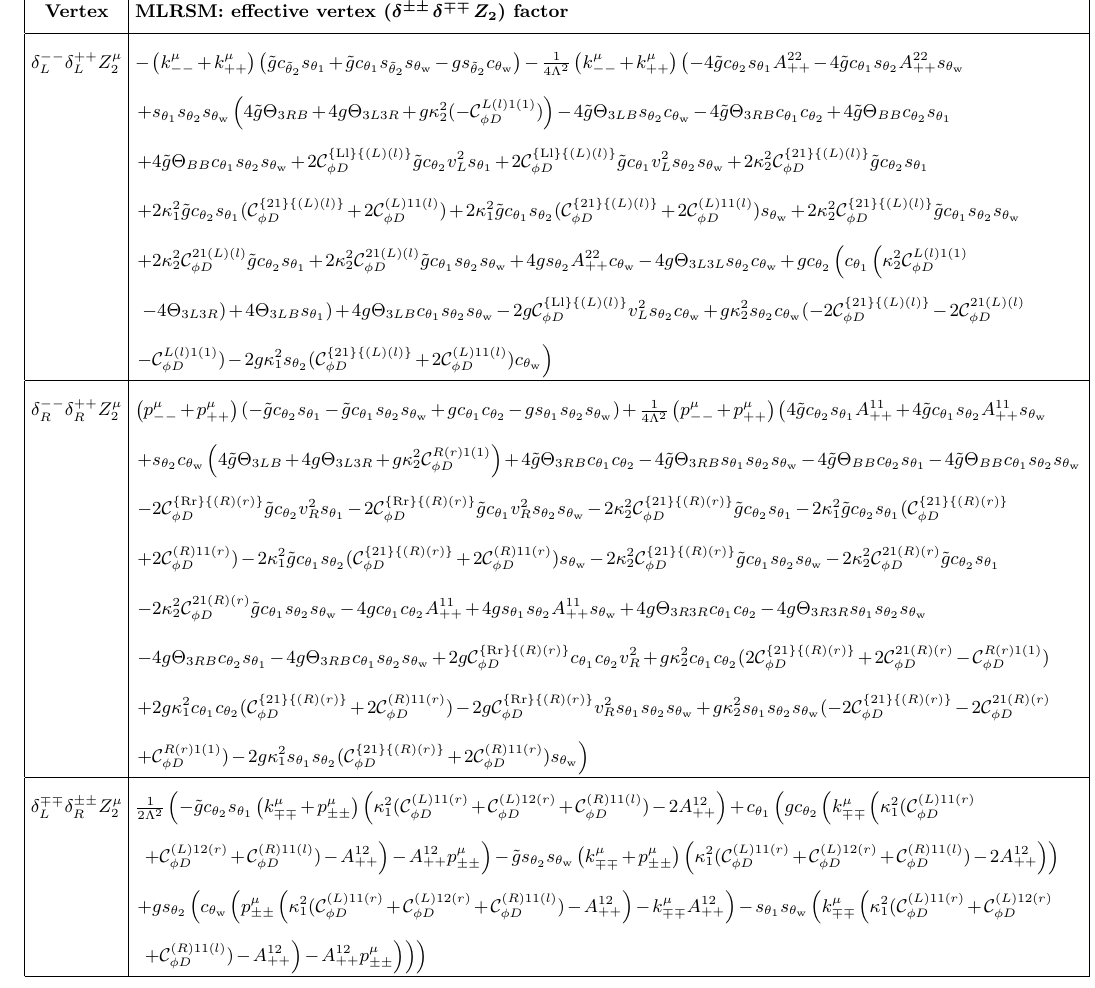
Table 41. MLRSM: coupling of a pair of doubly charged scalars ( (cid:14) (cid:6)(cid:6) ) with a neutral gauge boson ( Z 2 ). Here, s (cid:18) = sin (cid:18) i and c (cid:18) = cos (cid:18) i . k (cid:22) and p (cid:22) are the four momenta of (cid:14) (cid:6)(cid:6) (cid:6)(cid:6) (cid:6)(cid:6) i i respectively. ~ (cid:18) 2 is the rede(cid:12)ned angle de(cid:12)ned in eq. (6.102)